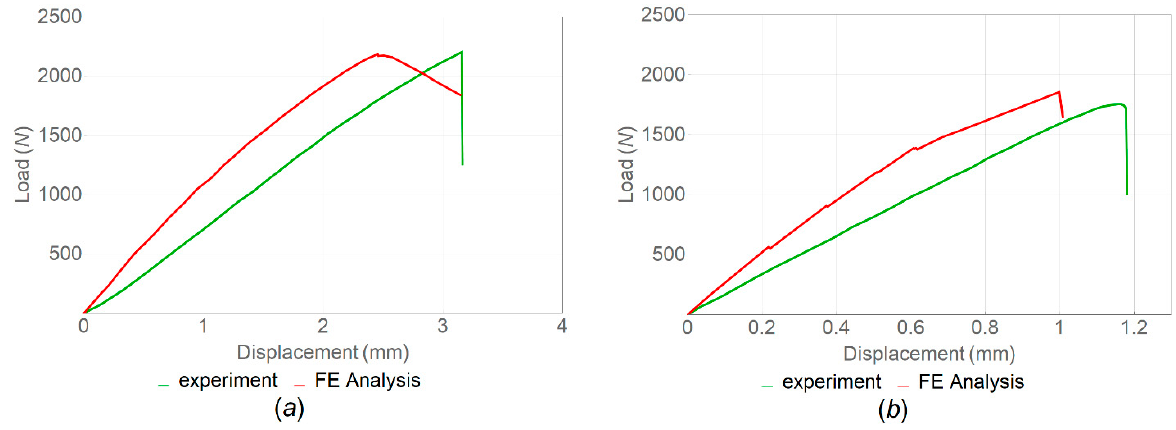
Figure 17. Load–displacements curves obtained from FE analysis and the experiments for samples with ( a ) and without ( b ) heat treatment.